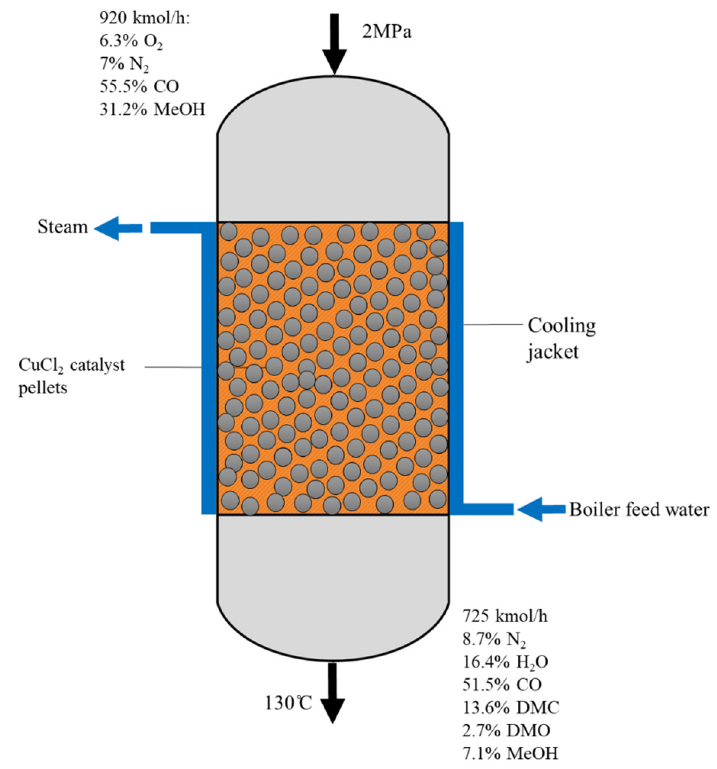
Figure 2. Schematic of the FBR and its specifications.